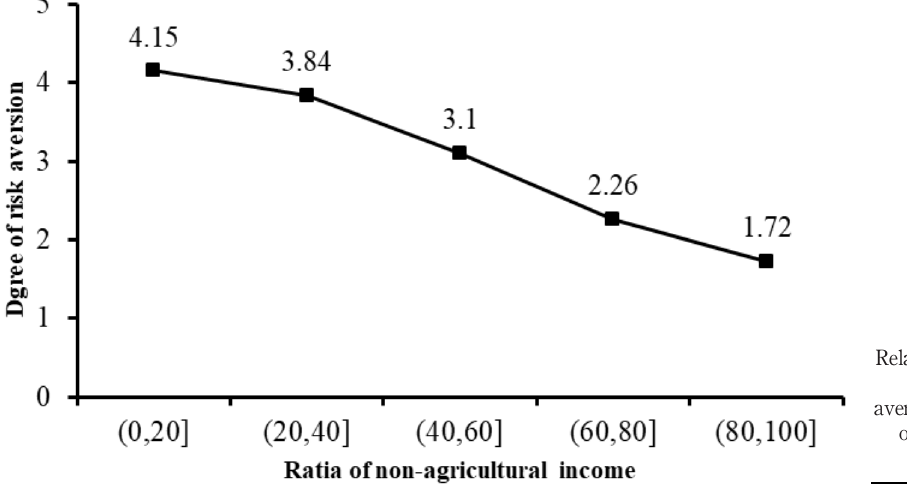
Figure 3. Relationship